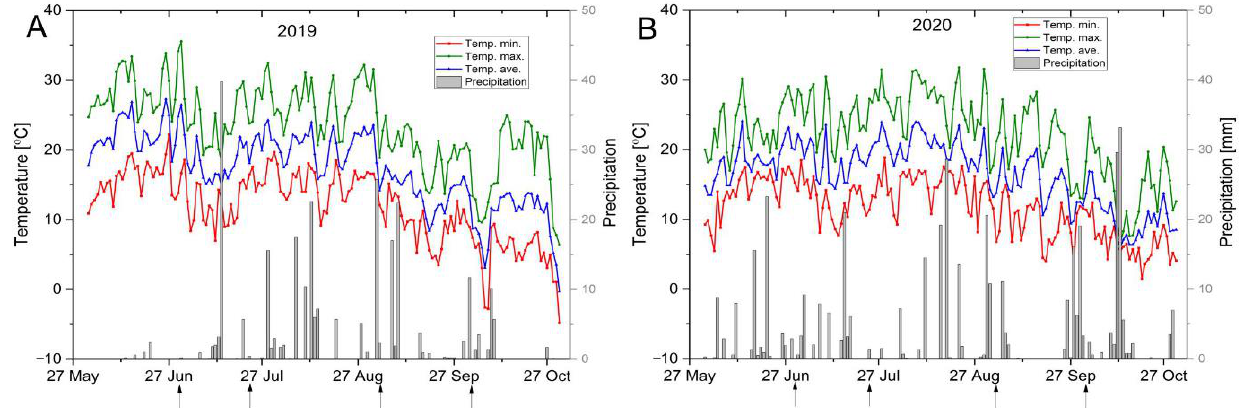
Figure 1. Weather conditions during the 2019 ( A ) and 2020 ( B ) sampling periods. The gray bars represent the daily precipitation in millimeters. The lines correspond to the maximum, minimum, and average temperatures ( ◦ C). The arrows indicate the sampling